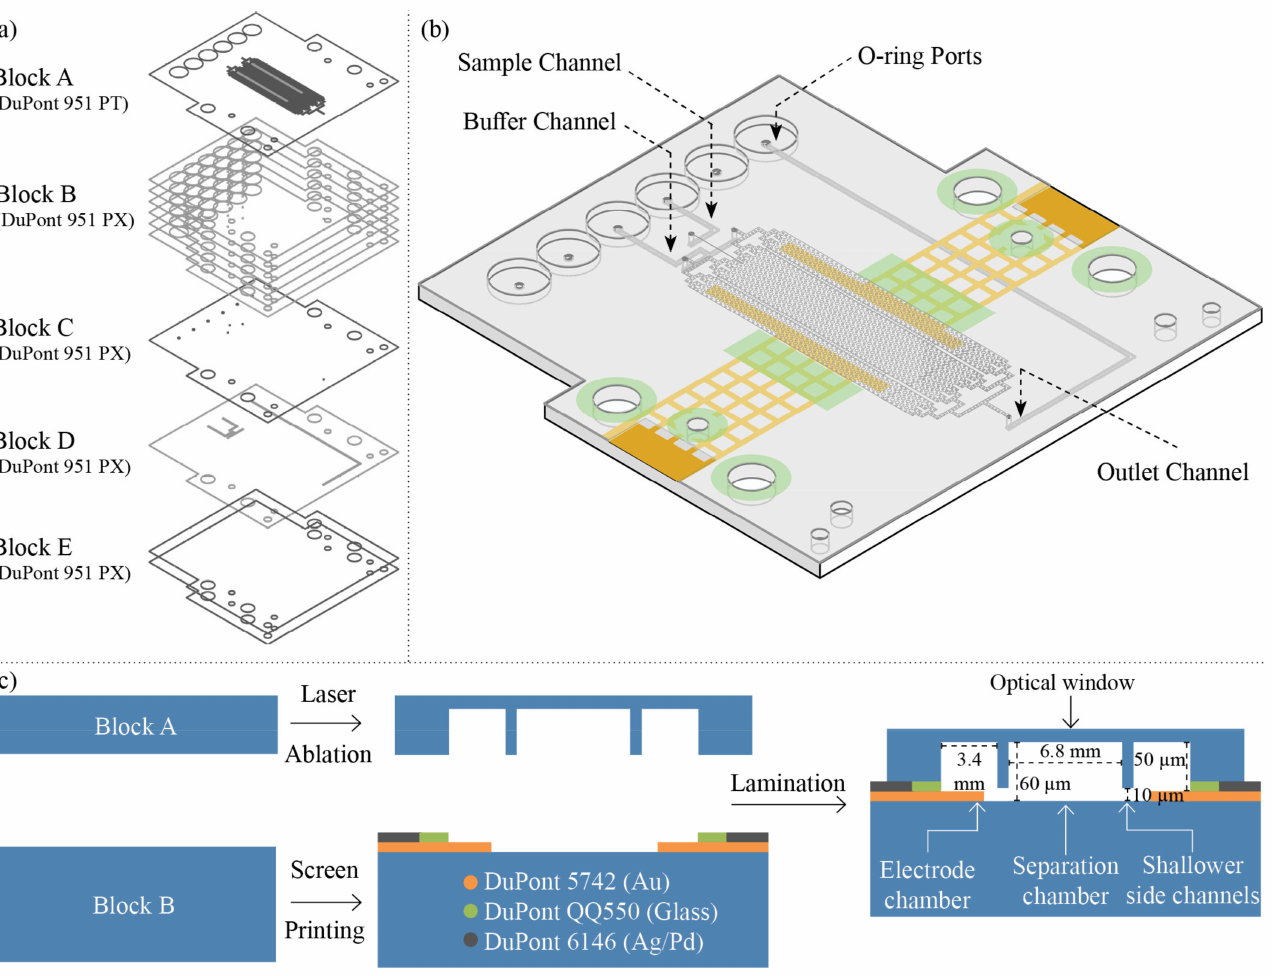
Figure 3. µ FFE design and fabrication methodology. ( a ) CAD schematic representation of the layers design arranged in lamination blocks. ( b ) Illustration of the three-dimensional structure of the fabricated monolithic FFE microfluidic device. ( c ) Schematic representation of the cross-section view of the laser ablation process of Block A, screen printing process of Block B, and the final µ FFE device (Not to